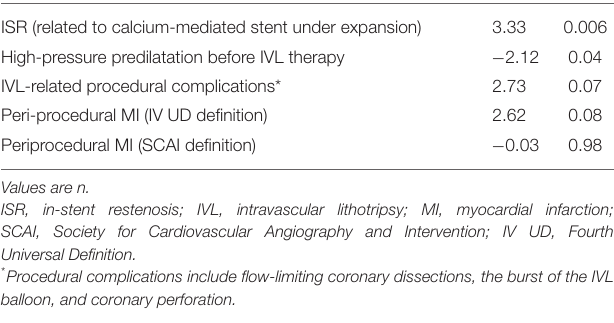
TABLE 7 | Multivariate procedural and periprocedural predictors of TLR by the logistic regression analysis.